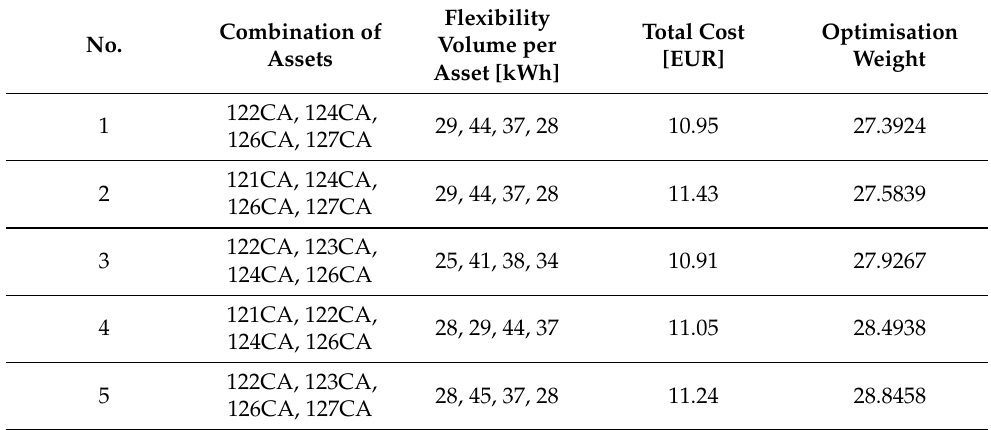
Table 3. Combination of aggregator